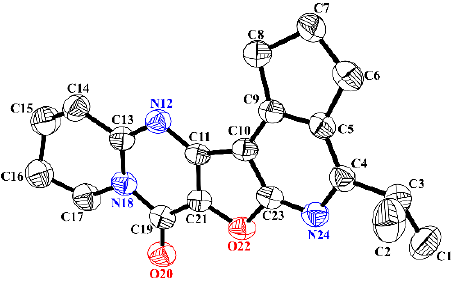
Figure 3. Single crystal X-ray structure of compound 6a .